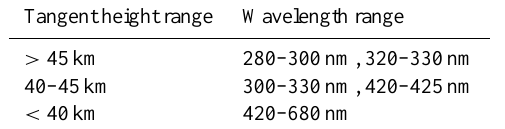
Table 1. Wavelength ranges used in the retrieval.